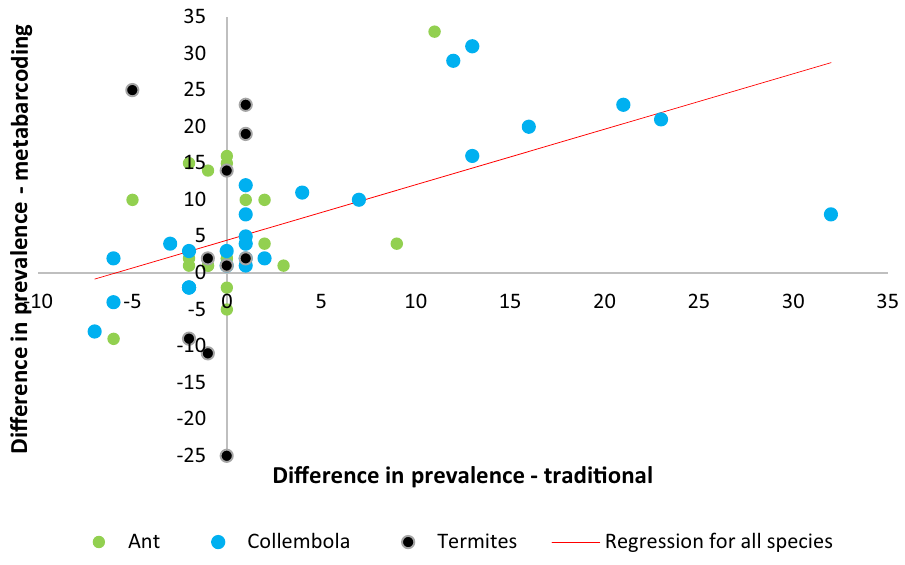
Figure 5. Plot of the difference in species’ prevalence between wet and dry season in traditional samples vs. that in metabarcoding samples.